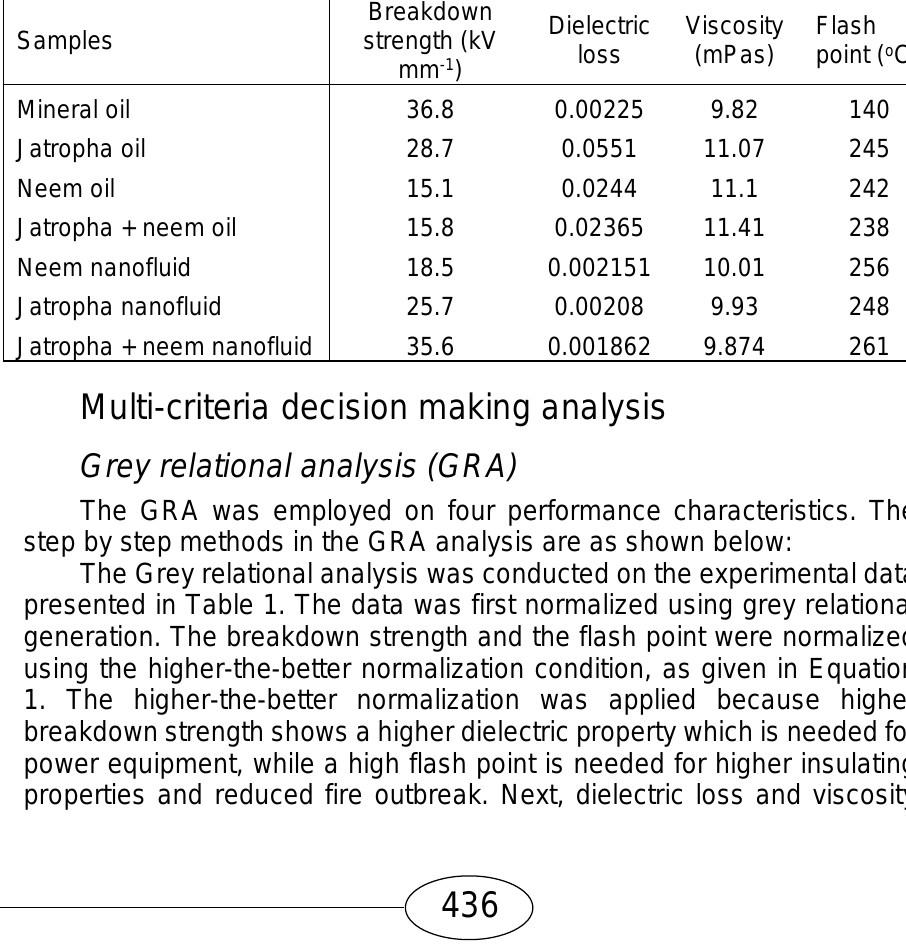
Table 1 – Insulating and electrical properties of different oil samples Таблица 1 – Изоляционные и электрические свойства различных образцов масел Табела 1 – Изолациона и електрична својства различитих узорака уља